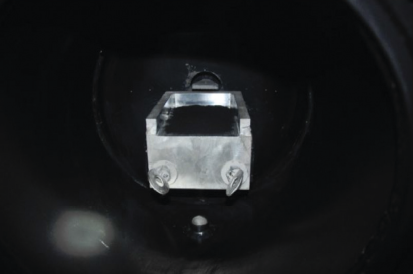
Figure 3: Sample tray installed in the 38L explosive chamber